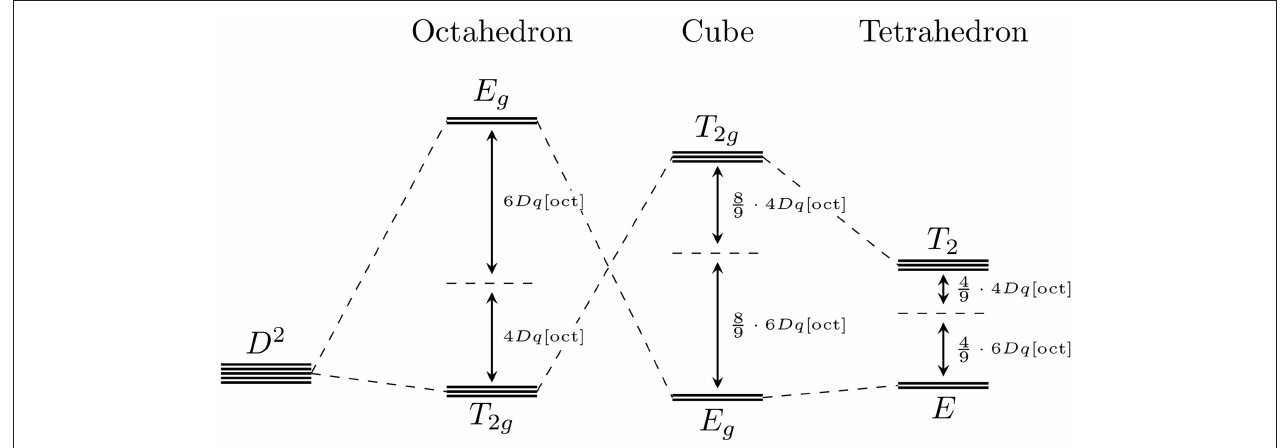
FIGURE 5 | The level splitting for a localized d -electron into E g ( E ) and T 2 g ( T 2 ) levels in an octahedral, a cubic and a tetrahedral crystal field.